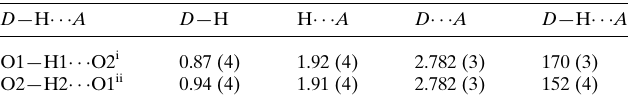
Table 1 Hydrogen-bond geometry (A˚ , (cid:2) ).